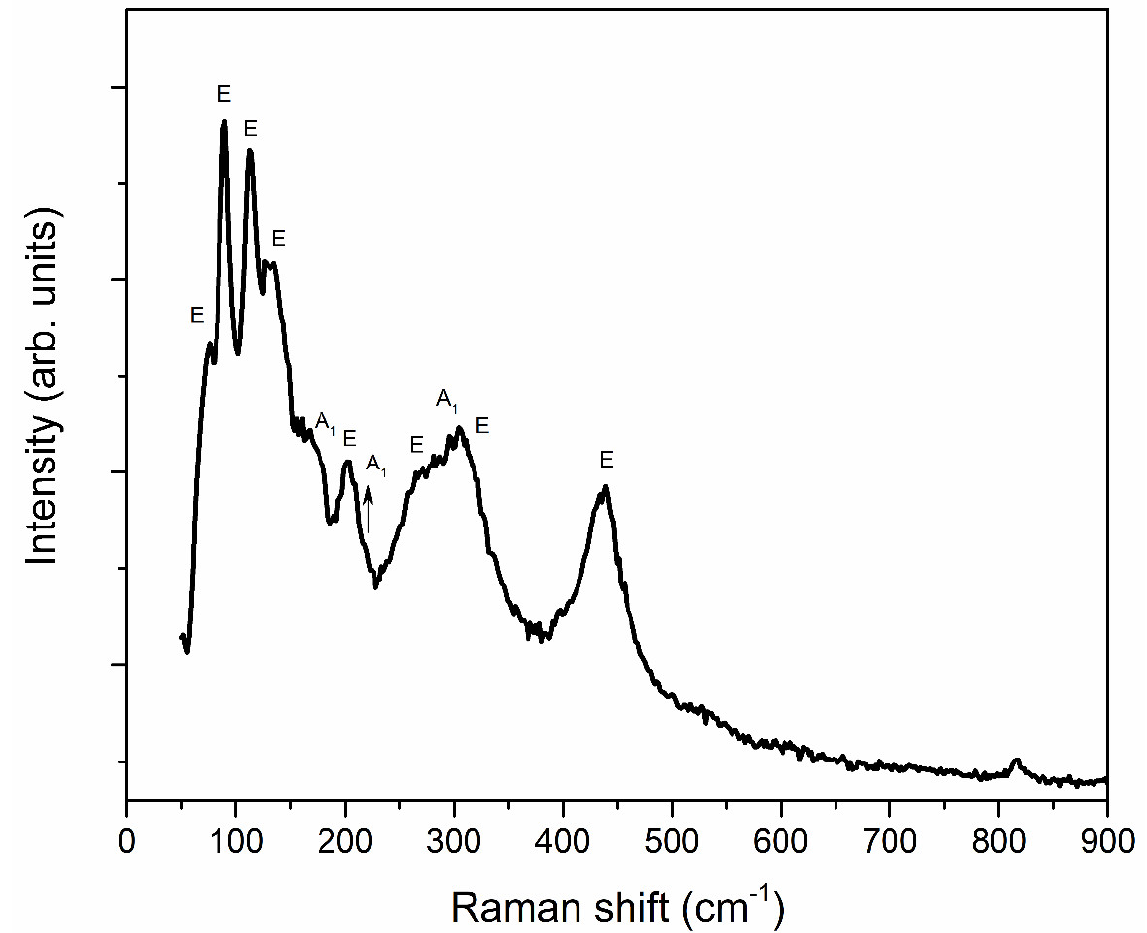
Figure 6. Raman spectrum of BiFeO 3 powder ceramics.